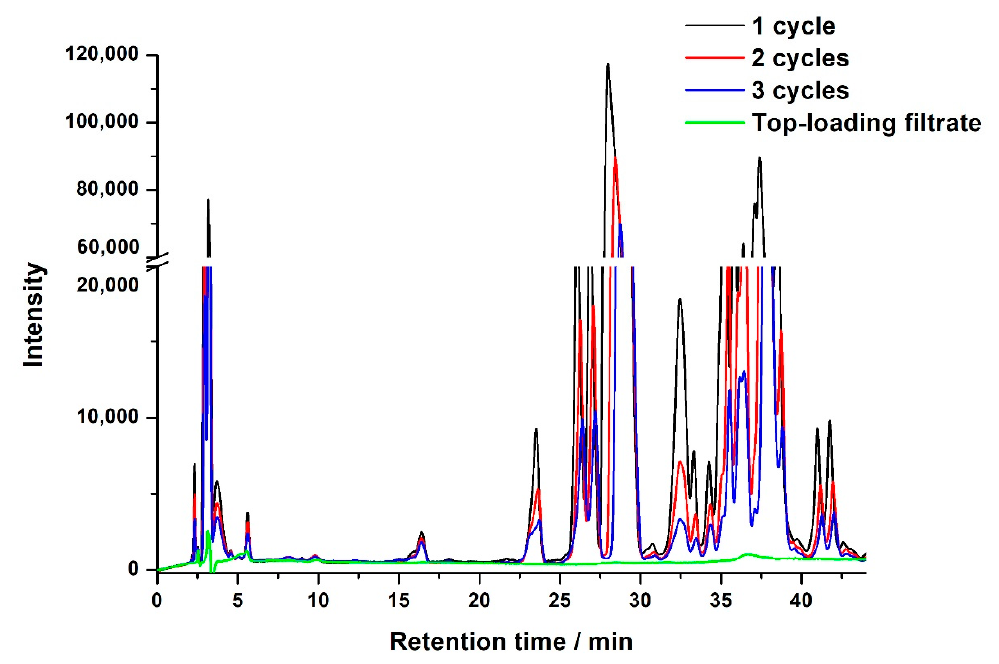
Figure 4. Representative chromatogram of the extract after different in–out cycles using draw-in sample loading, and the filtrate solution after top-loading.